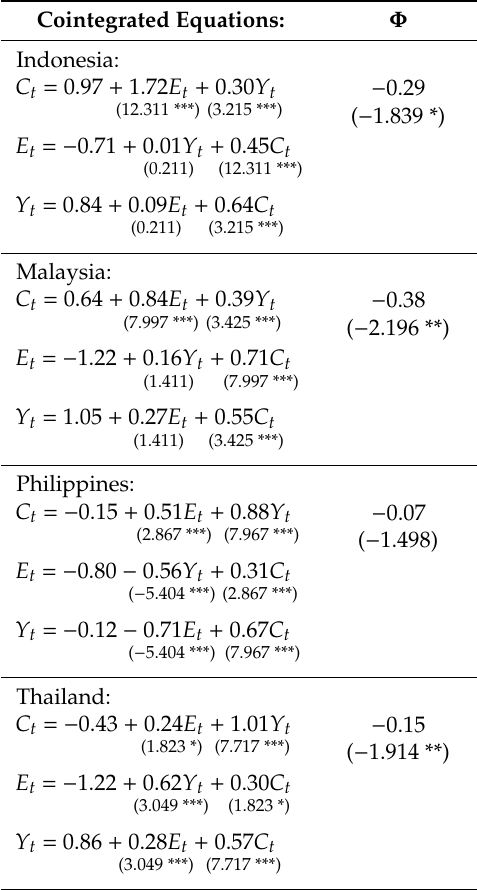
Table 5. Cointegrating vector.